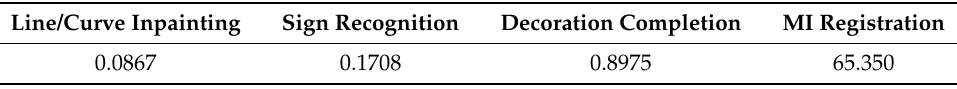
Table 2. Average processing time of each step of the registration pipeline for every fragment expressed in